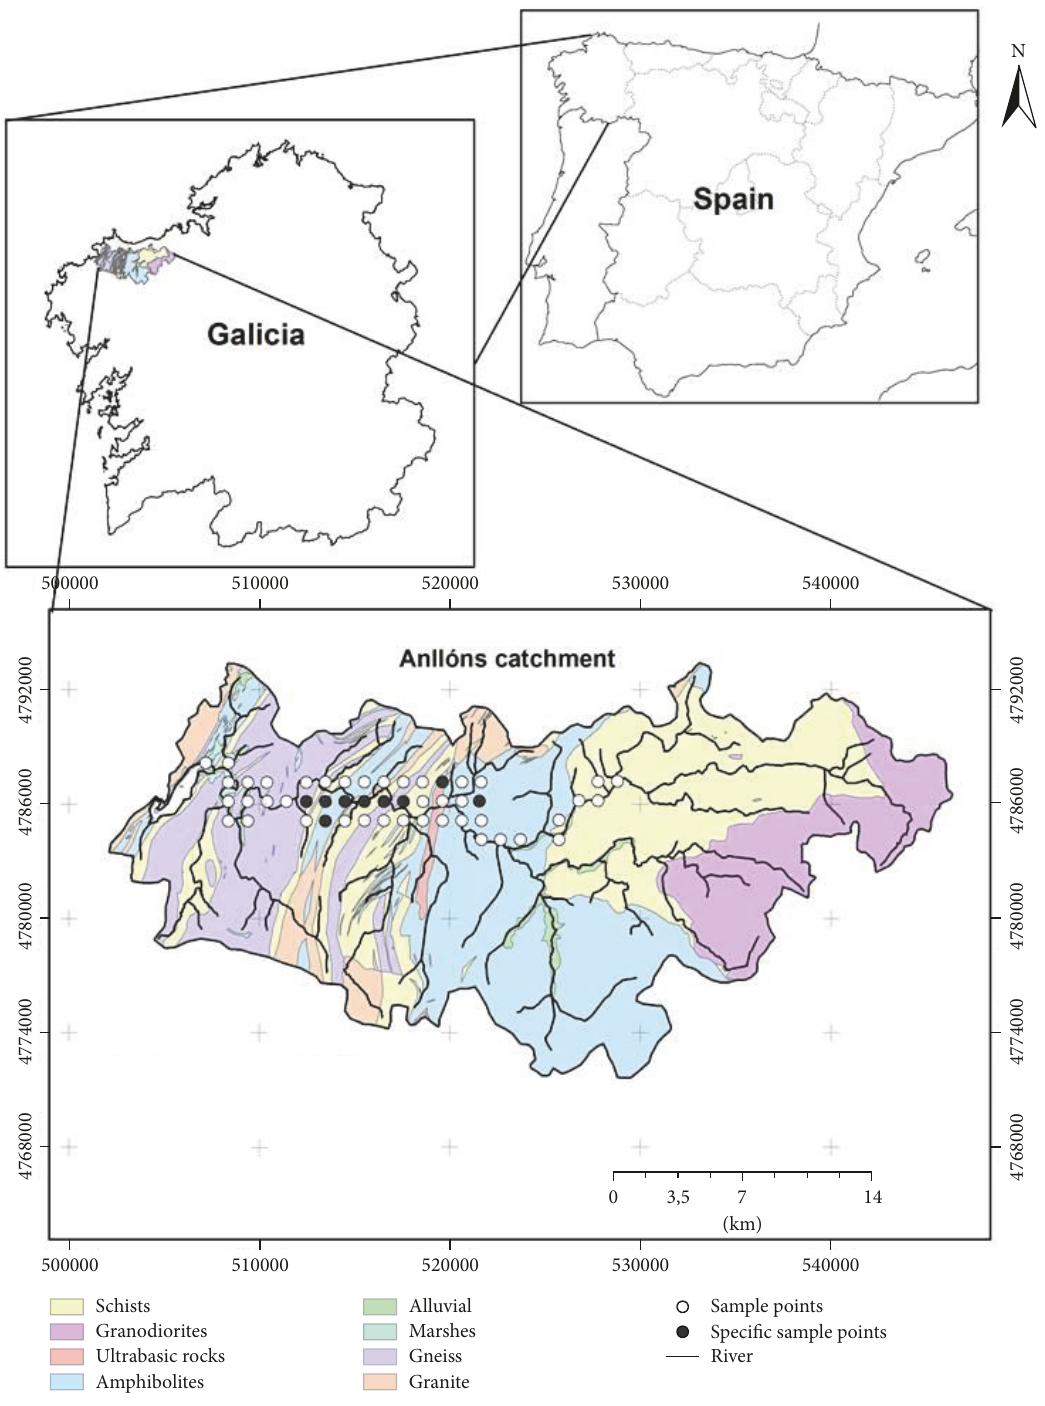
Figure 1: Location and geology of the Anll´ons River catchment and location of the sampling points for the exploratory analysis and detailed specific